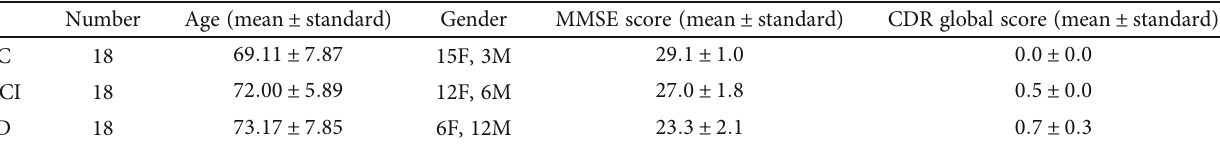
Table 1: Demographic information for HC, MCI, and AD